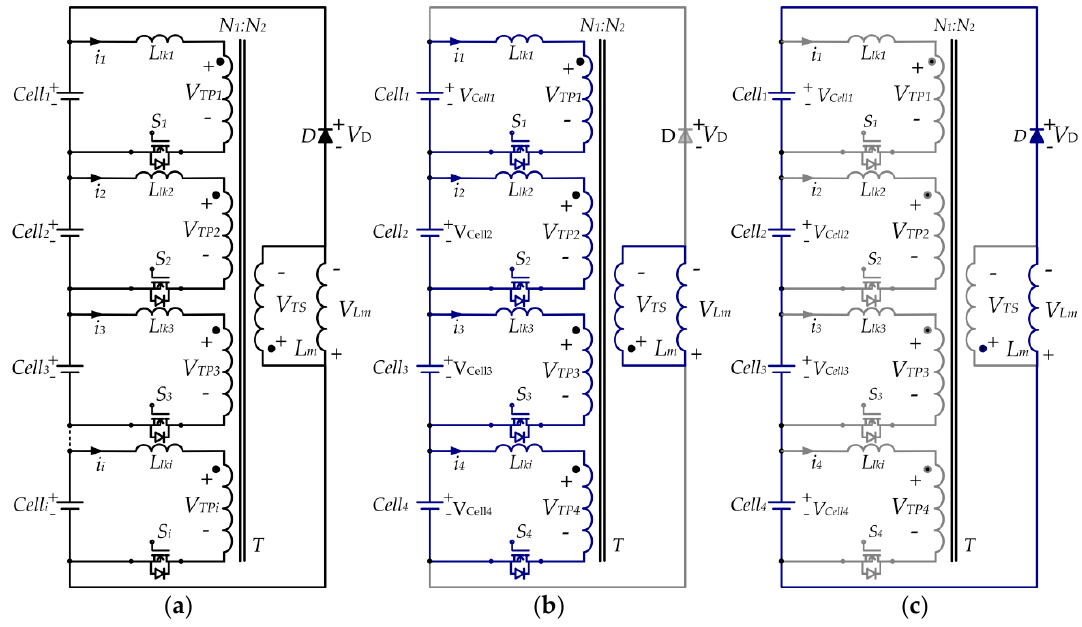
Figure 2. The MWTFC based on the balancing circuit [21]: ( a ) Circuit diagram; ( b ) Mode 1; ( c ) Mode 2.